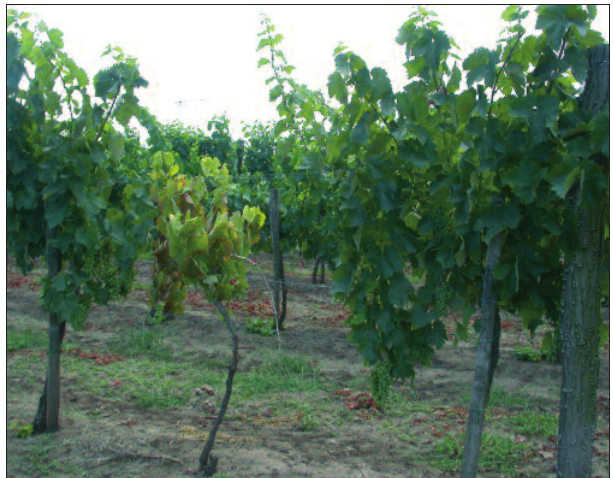
Fig. 5. Diseases stock (Fitoplasma)